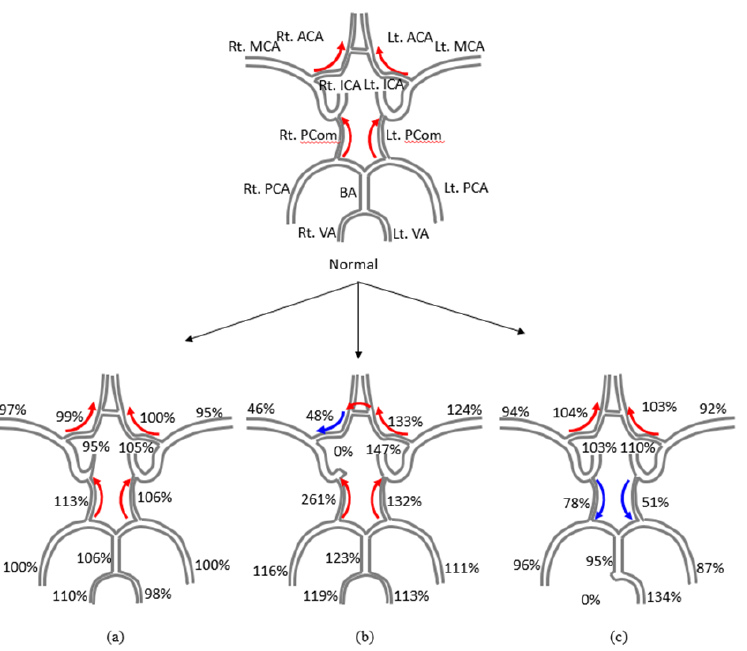
deviation; VA, vertebral artery.